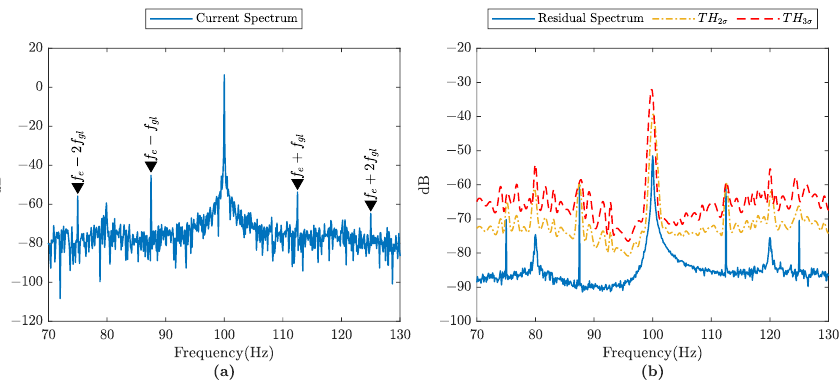
Figure 7. Gear-to-gear spectrum: ( a ) motor current spectrum; ( b ) residual current spectrum.